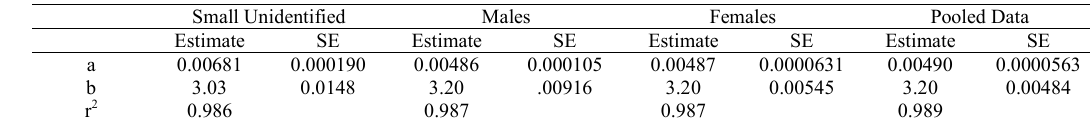
Table 2. Parameter estimations for the length/weight relationships of Atherinella brasiliensis (a=proportionality coefficient; b=allometric coefficient).